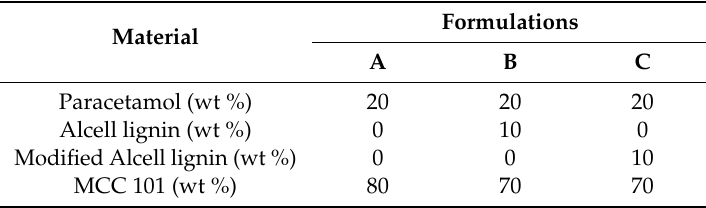
Table 1. Various formulations used in this